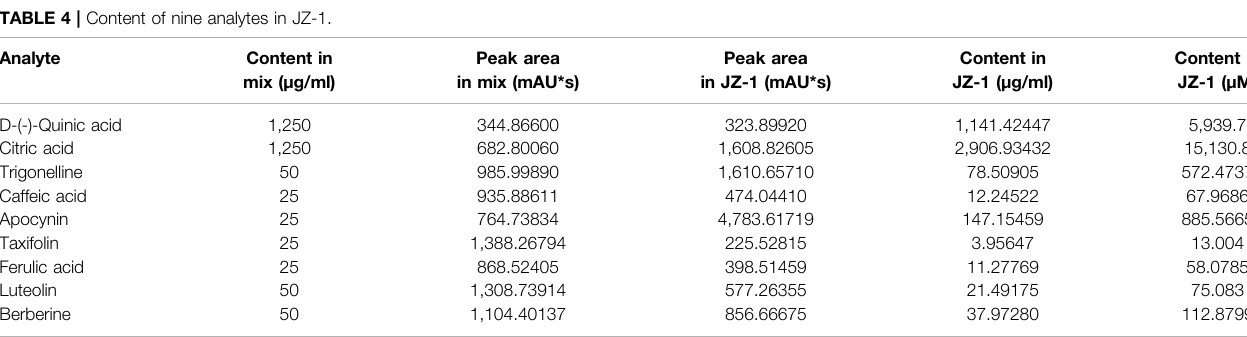
TABLE 4 | Content of nine analytes in